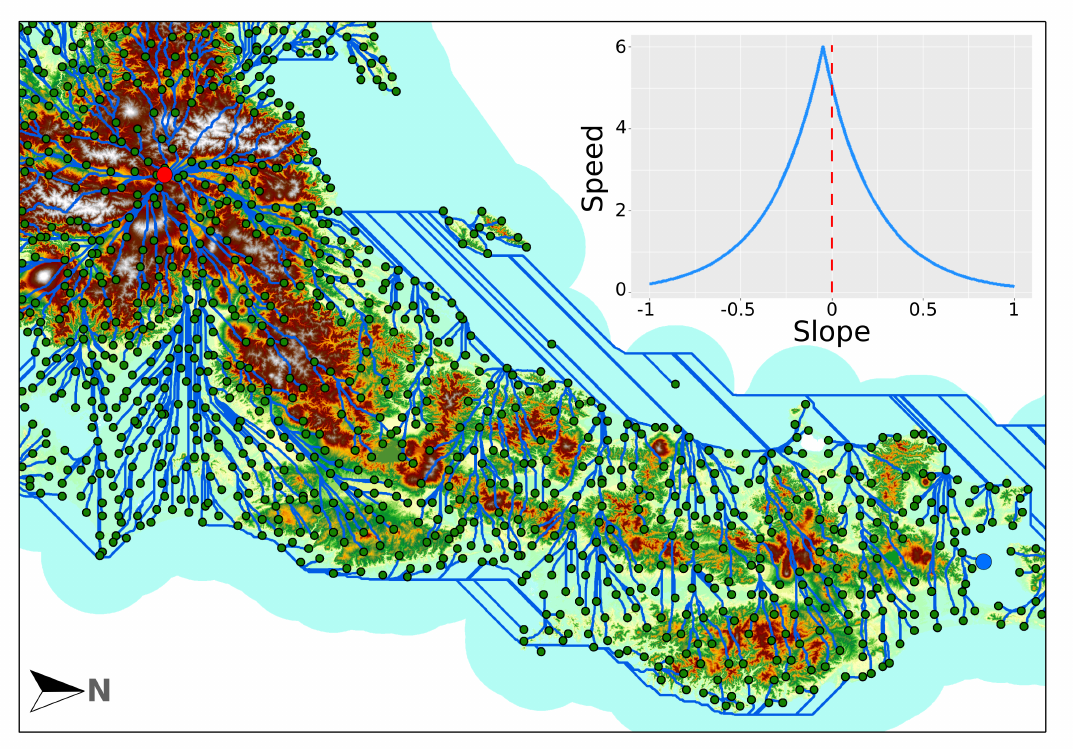
Figure 5. Representation of the least cost paths in our model with a starting point in the Japanese Alps (Nagano prefecture). Tobler’s hiking function is shown in the top right corner with speed (km/h) as the function of slope